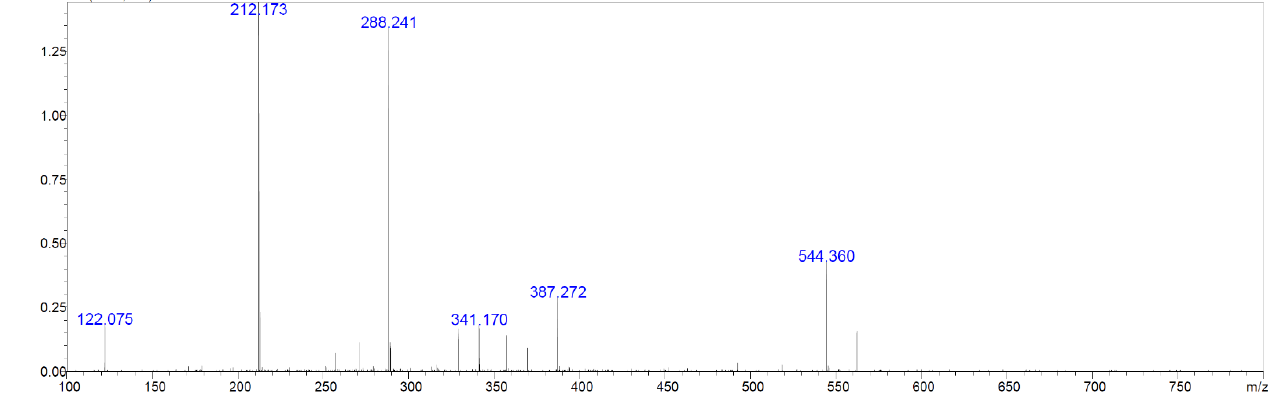
Figure 8. LC-MS chromatogram of the isomer of dichloro-3-O-methylanthrabenzoxocinone (M = 543.393 Da).